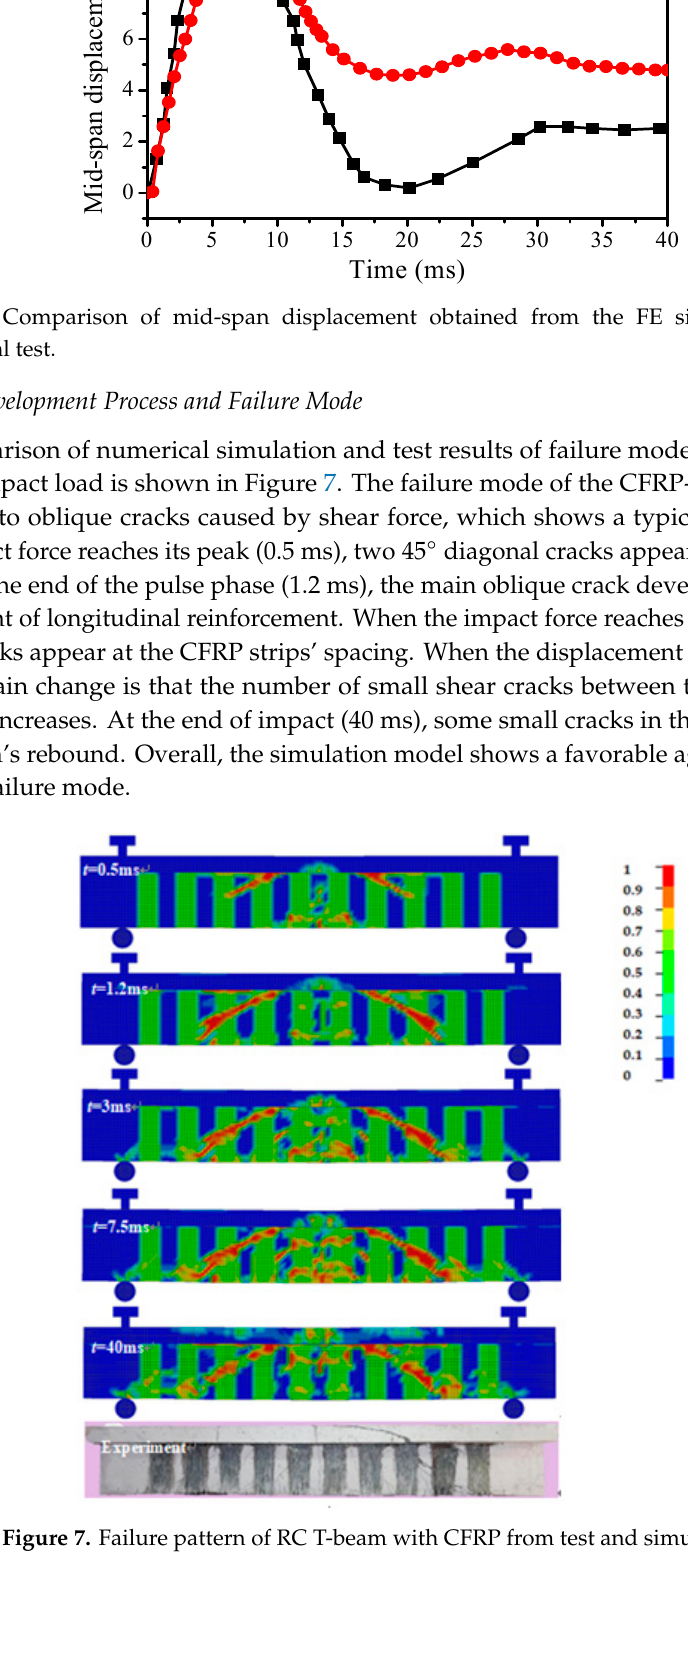
Experimental FE Figure 5. Comparison of reaction force time histories obtained from the FE simulation and experimental test. 4.2. Displacement The comparison of mid-span displacement obtained from the FE simulation and the experimental test are shown in Figure 6. It can be noted that mid-span displacement time history presents a half-sine wave. This indicates the partial elastic recovery when the displacement achieves